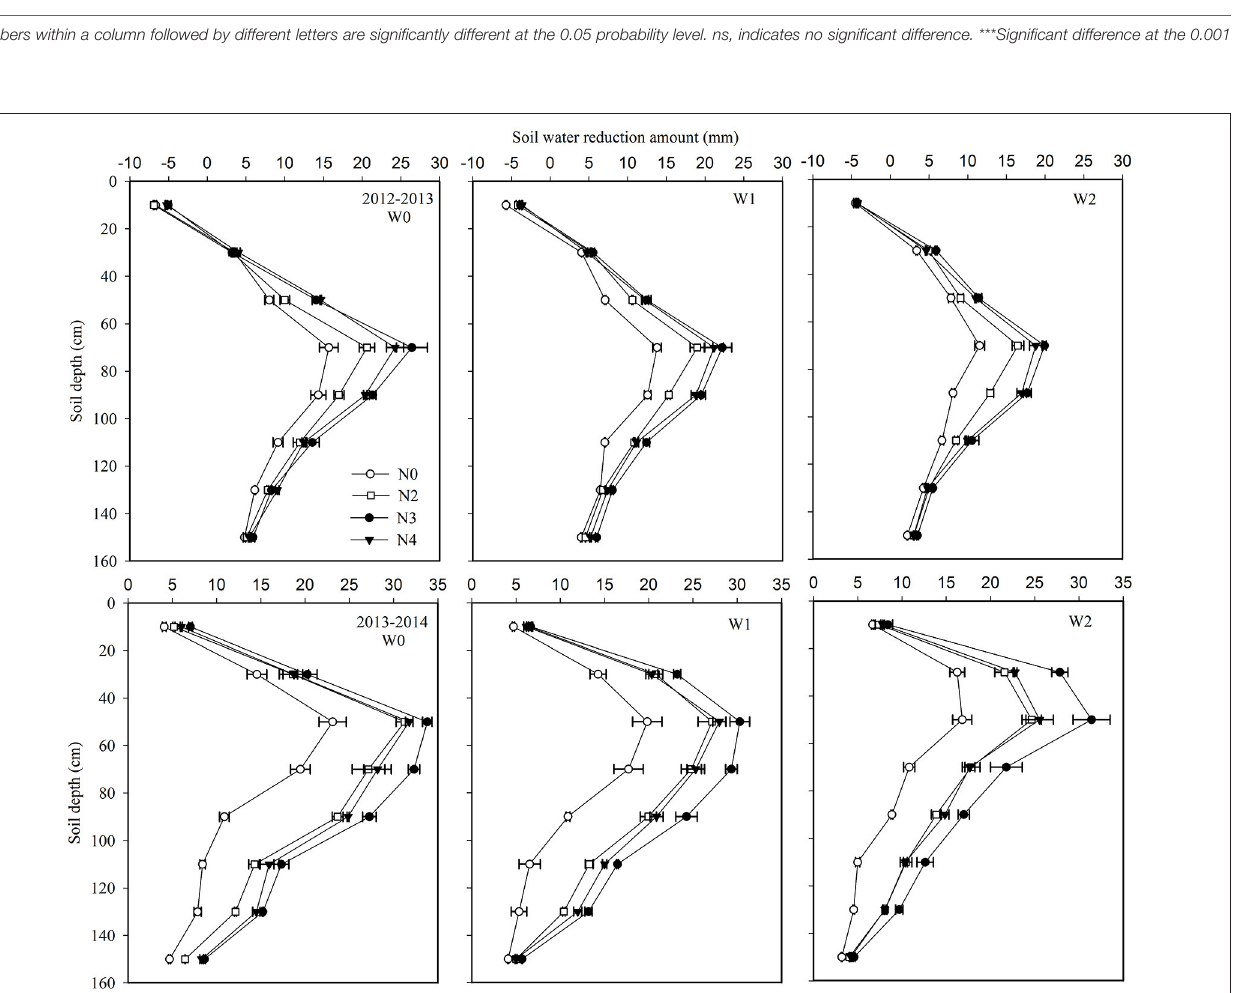
Frontiers in Plant Science |